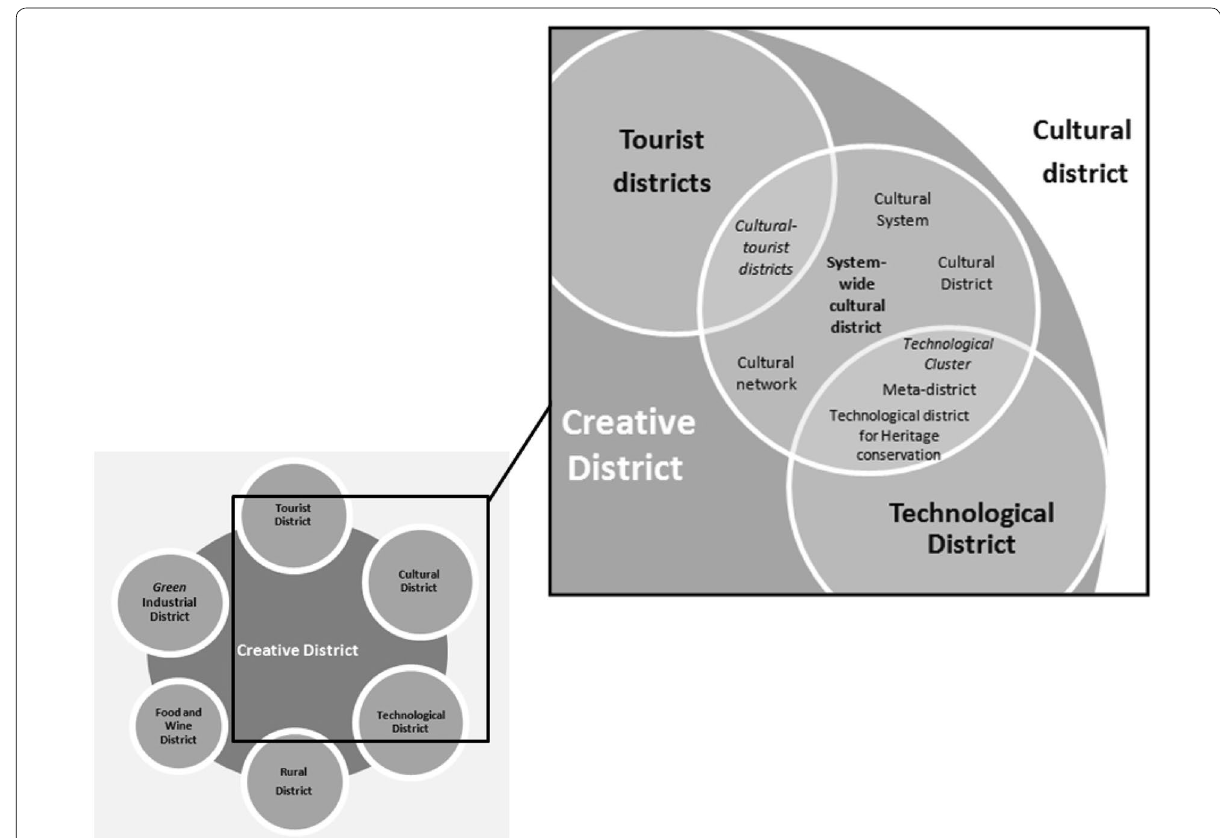
Fig. 2 The ecosystem model applied to SMEs in economic studies on innovation and to cultural/creative ecosystems: the cultural district as an umbrella concept (Source: elaboration of the